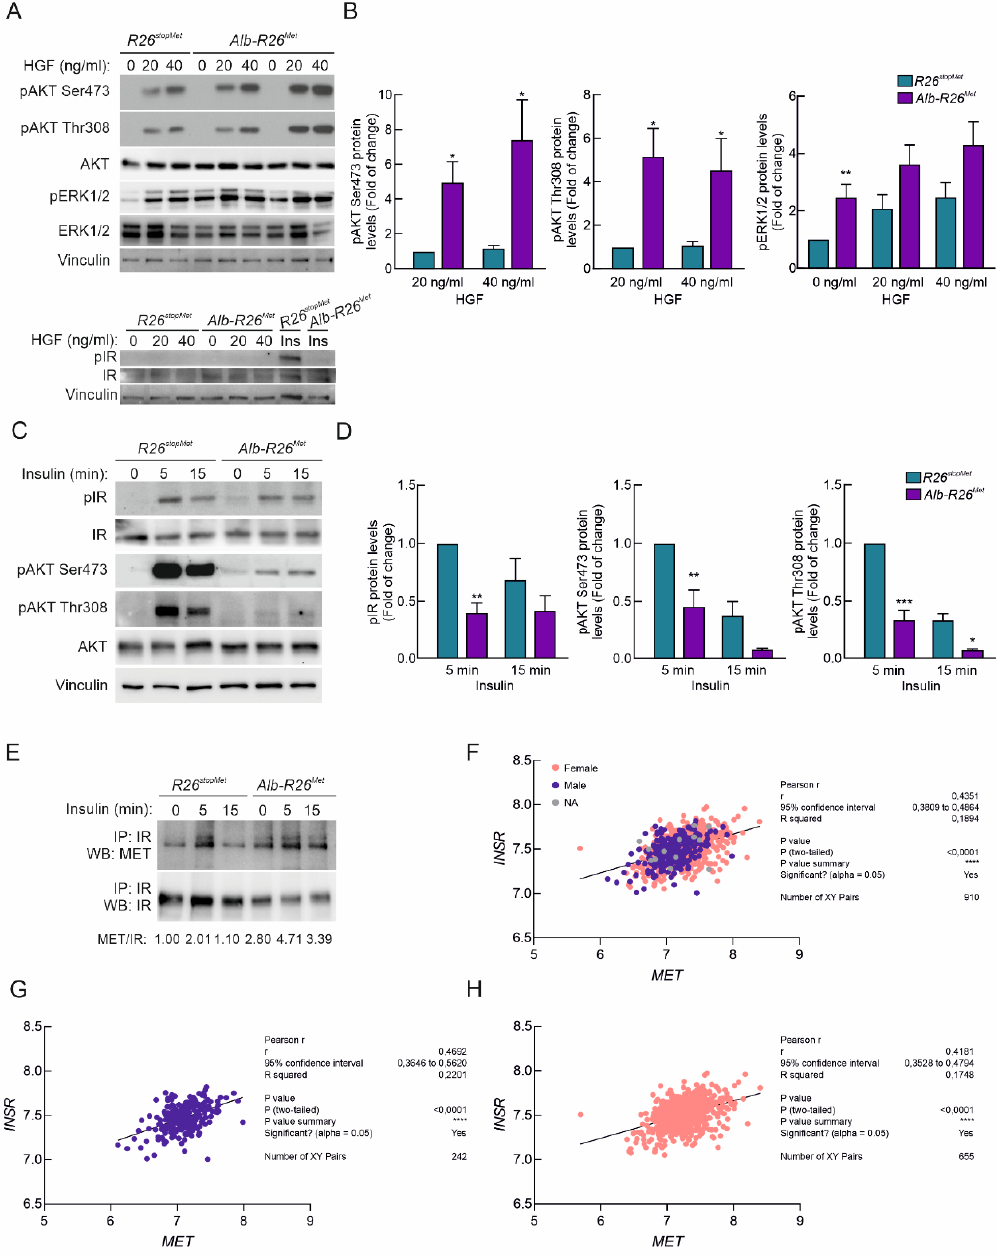
Figure 6. Hepatic enhanced MET levels lead to reduced insulin sensitivity in primary hepatocytes. ( A ) Primary mouse hepatocytes from R26 stopMet and Alb-R26 Met mice were exposed to HGF (40 ng/mL) for 15 min. Upper panel: phosphorylation levels of pAKT and pERK1/2 were analyzed. Vinculin, AKT, and ERK1/2 were used as loading controls. Lower panel: phosphorylation levels of IR were analyzed. IR and Vinculin were used as loading controls. ( B ) Densitometric quantification of the indicated protein levels shown in ( A ). ( C ) Primary mouse hepatocytes from R26 stopMet and Alb-R26 Met mice were exposed to insulin (10 nM) for 5–15 min. Phosphorylation levels of IR and AKT were analyzed. IR, AKT, and Vinculin were used as loading controls. ( D ) Densitometric quantification of the indicated protein levels shown in ( C ). ( E ) IR was immunoprecipitated from R26 stopMet and Alb-